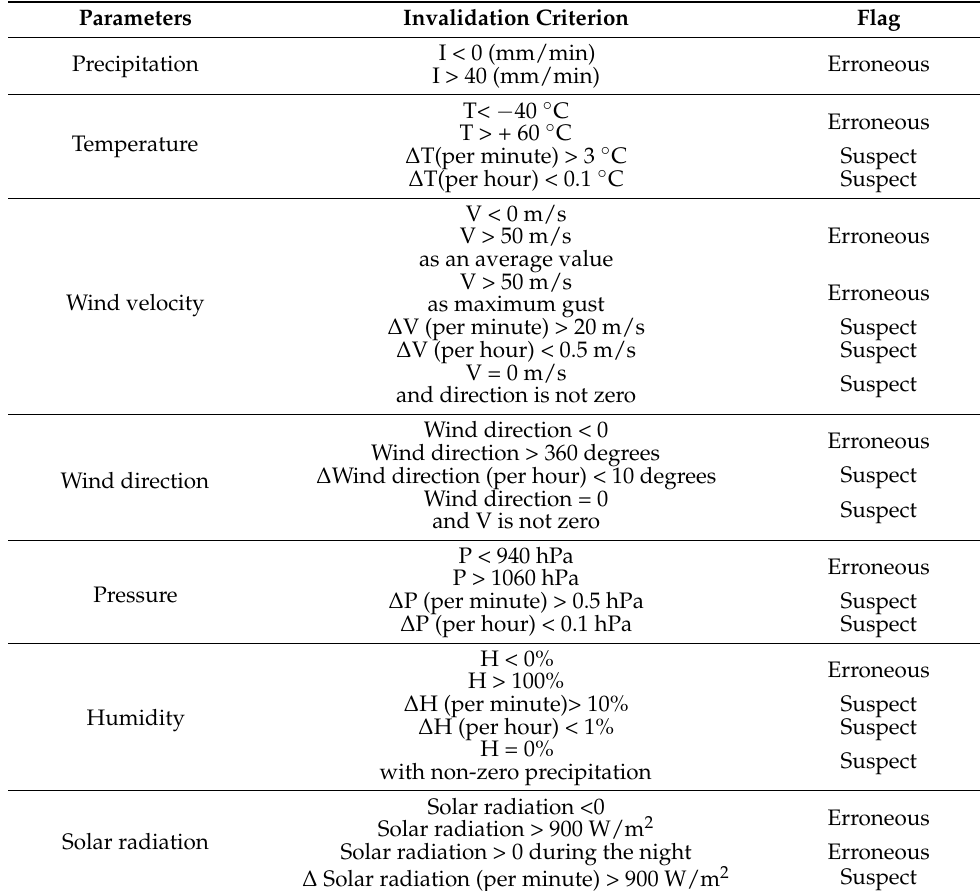
Table 1. Validation criteria for the control unit that were adopted, including those parameters for which there are no experimental data yet